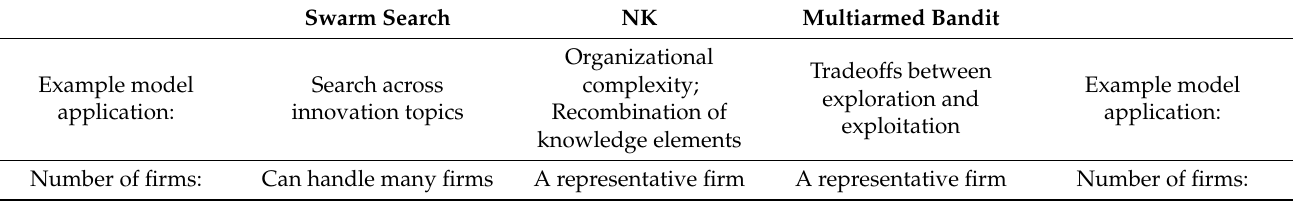
Table 7. Comparison across models on various dimensions important to firm search. Swarm